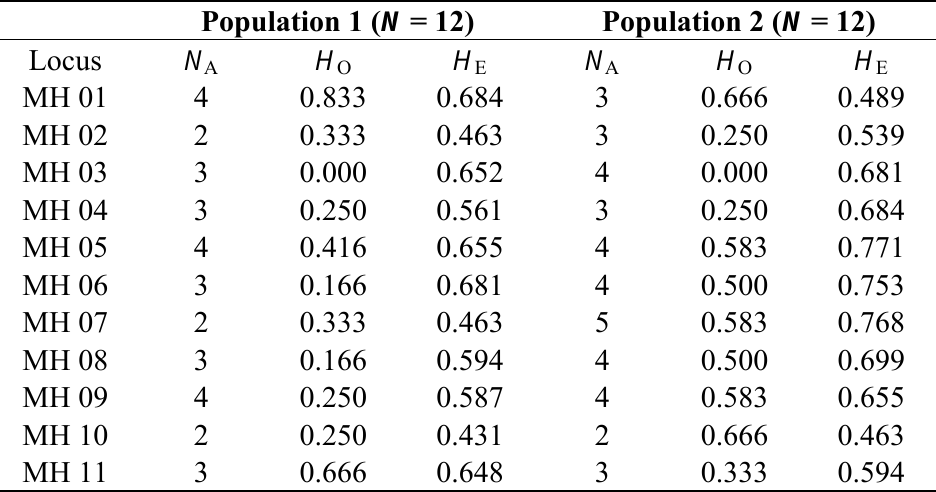
Table 2. Results of 11 polymorphic microsatellite loci screening in two populations of Luculia yunnanensis